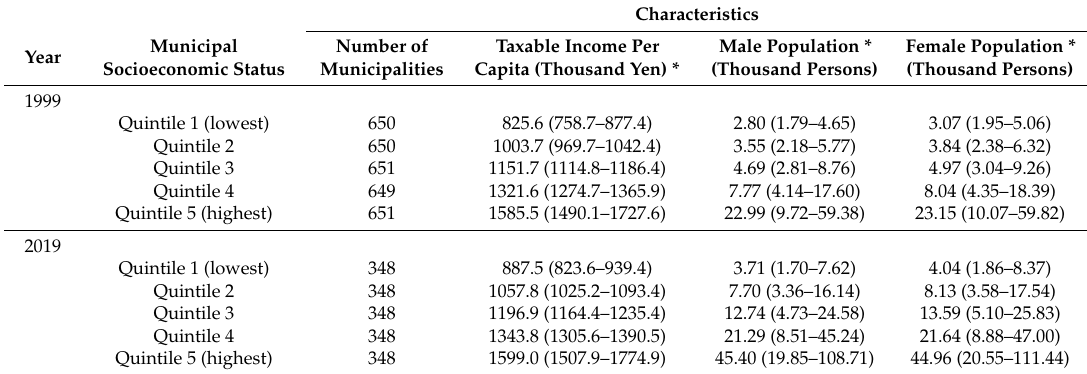
Table 1. Basic characteristics of each municipal socioeconomic status quintile.